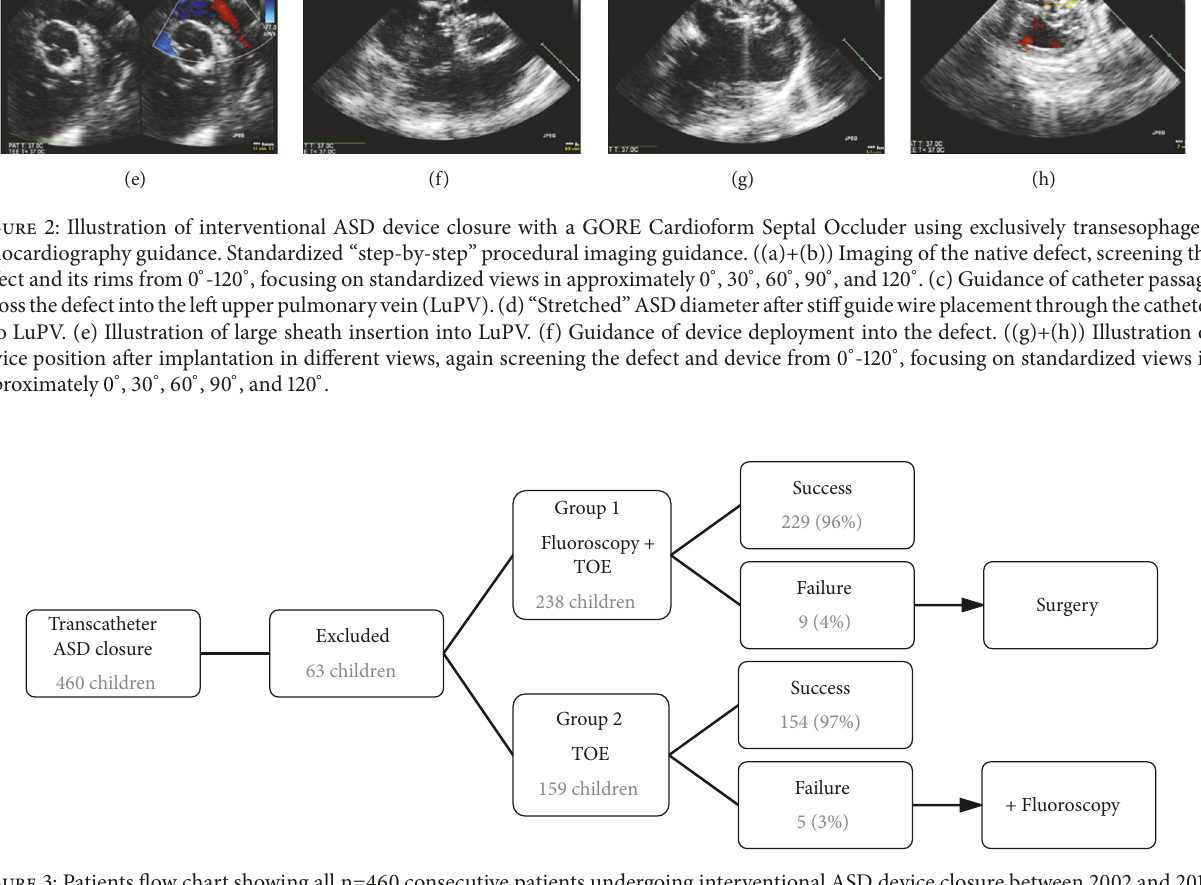
to the device size implanted, only self-centering devices as the Amplatzer (cid:2) Septal Occluder (AGA Medical, Golden Valley, MN, USA), NitOcclud (cid:3) ASD-R-Device (PFM Medical AG, Cologne, Germany) and CeraFlex (cid:2) ASD Occluder (Lifetech scientific, Shenzhen, China) were analysed to over- used [e.g., Solysafe (cid:2) Septal Occluder (Swissimplant AG, Occluder (GORE Medical, Flagstaff, AZ, USA)]. viewed for residual atrial shunt, patients’ weight and